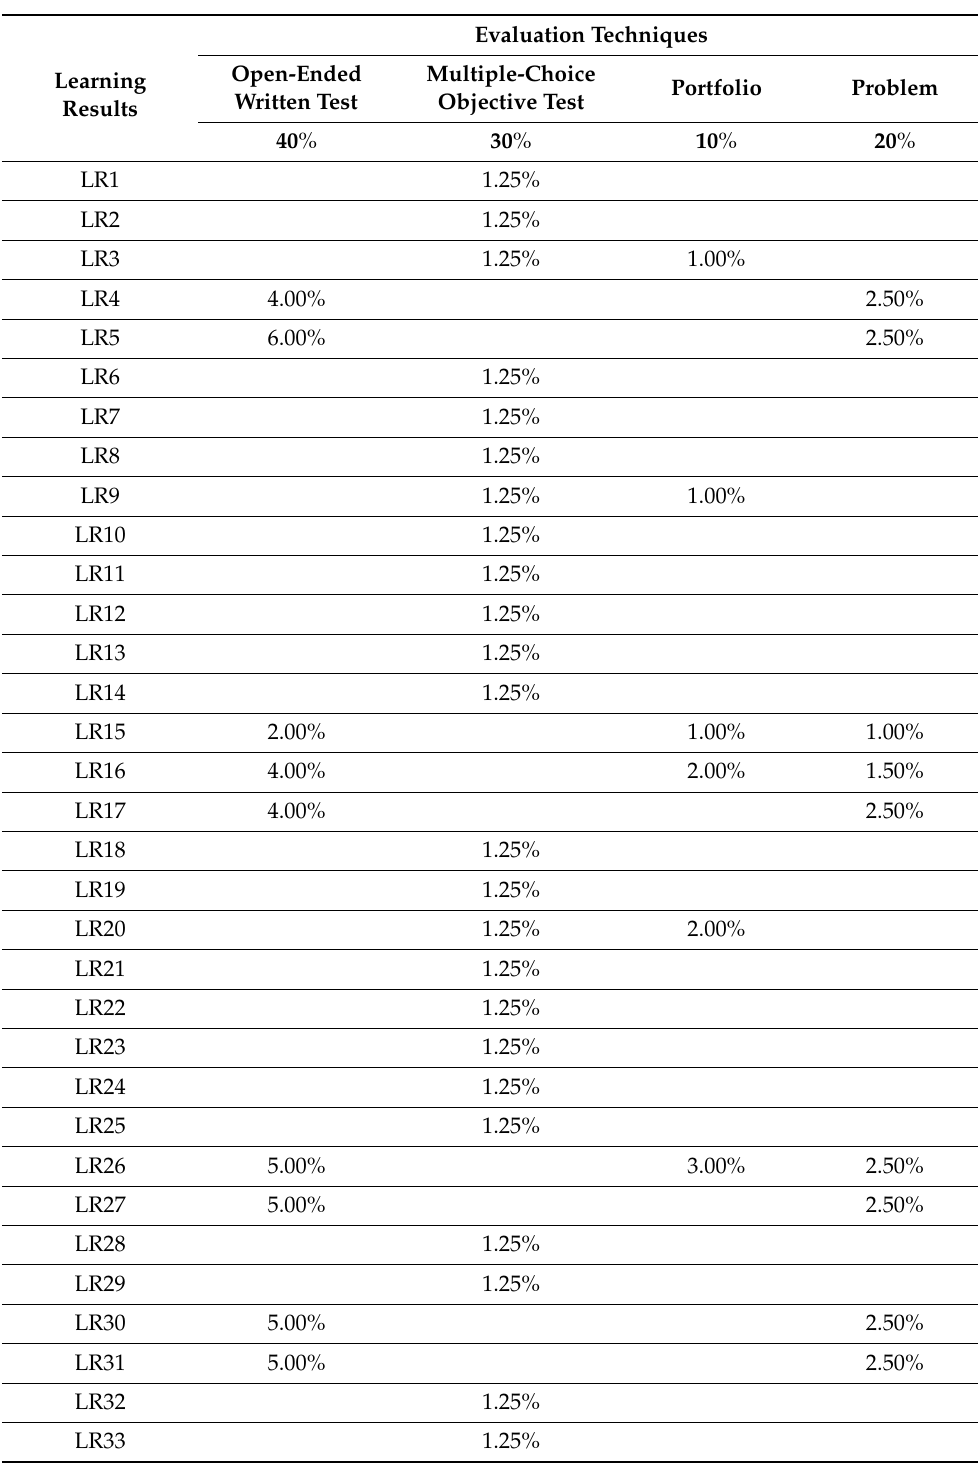
Table 5. Evaluation matrix of the course on energy